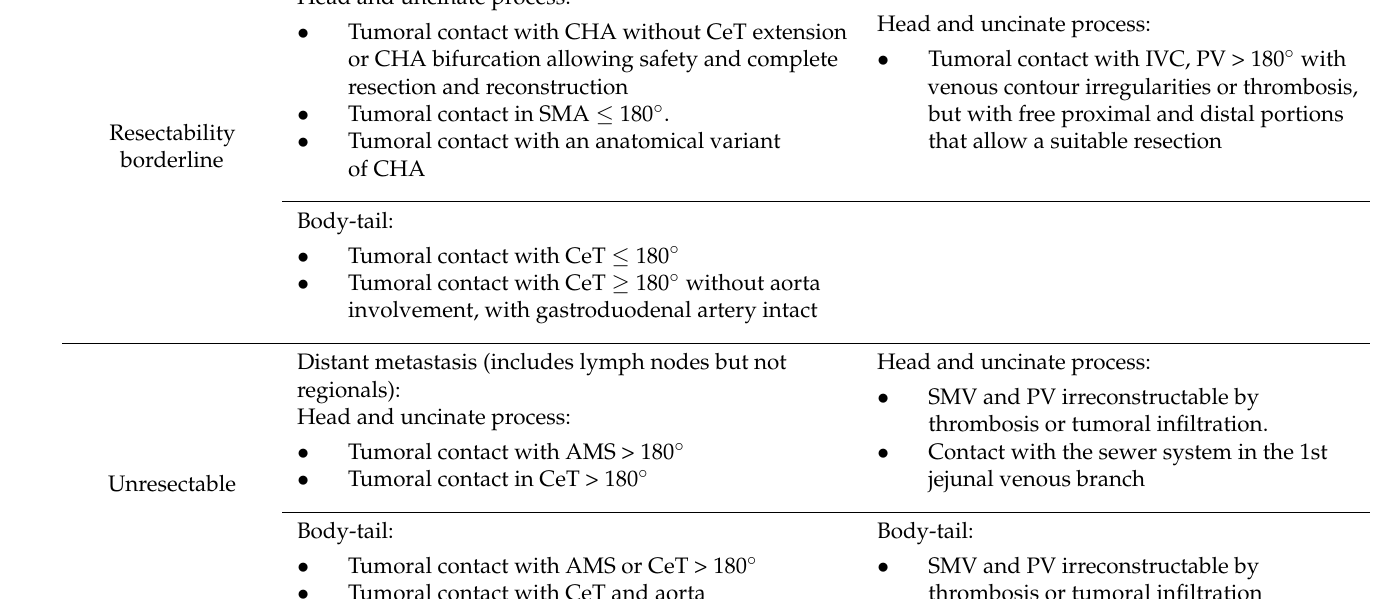
Table 1. Definition criteria of resectability by NCCN v 1.2019.